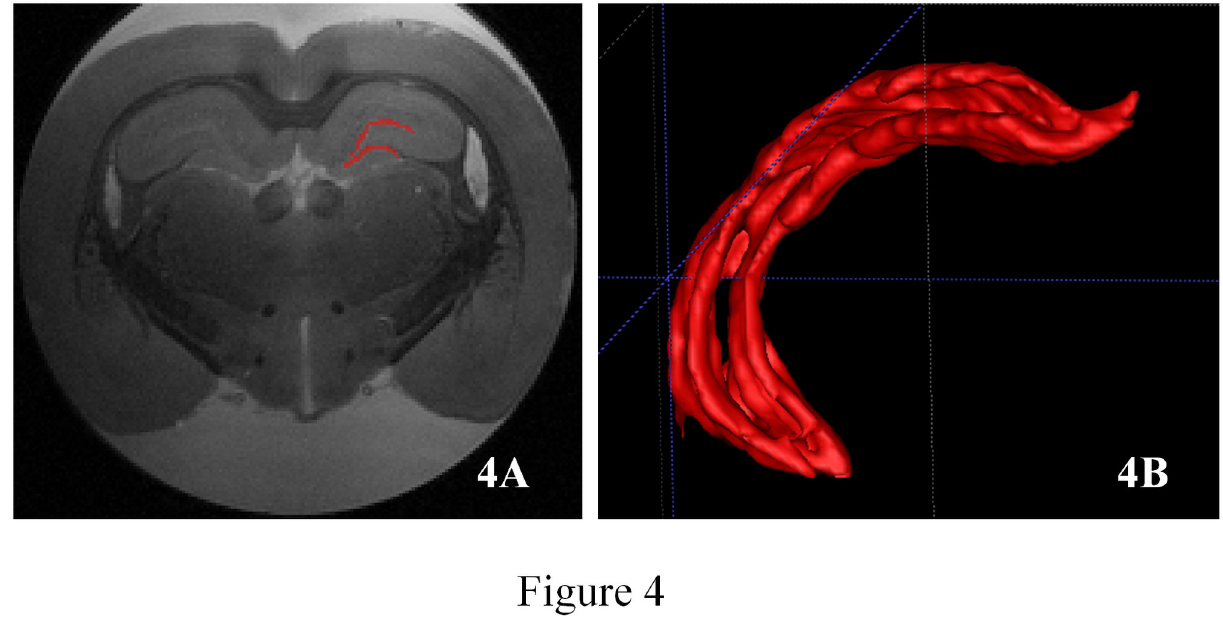
Figure 4. 3D representation of stratum granular. Segmentation and volume rendering of the stratum granulare of the dentate gyrus. 4A Segmentation of stratum granulare on dorsal hippocampus, 4B Volume rendering of stratum granulare of the dentate